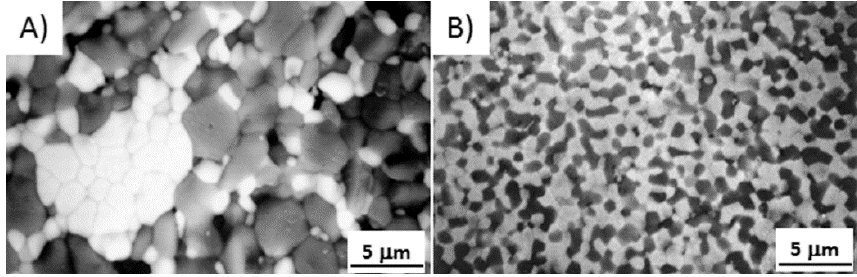
Figure 13. SEM micrographs of Al 2 O 3 /50 vol. %YAG sintered materials, prepared by ( a ) traditional mixing route and ( b ) co-precipitation, both sintered at 1600 °C for 3